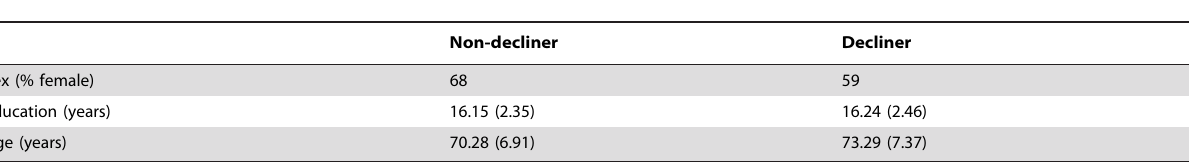
Table 1. Demographic Variables by